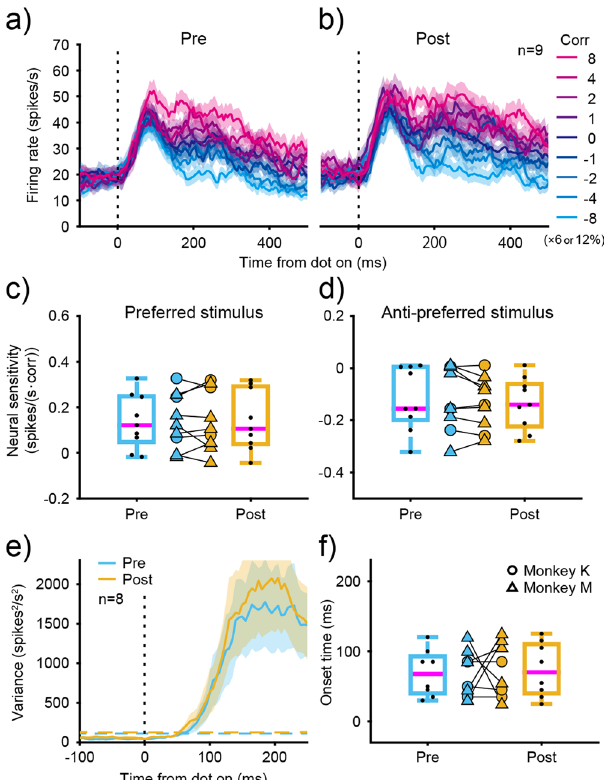
Fig. 6 Effects of ketamine on MT responses during the direction- discrimination task. Average fi ring rates of 9 MT neurons aligned to visual stimulus onset are plotted before ( a ) and after ( b ) ketamine administration. Each colored line denotes fi ring rates at different binocular correlation with motion coherence fi xed at zero. Dotted-vertical line denotes the time of visual stimulus onset. Shaded area denotes SEM. c , d MT sensitivity to binocular correlation before and after administration. The binocular correlation-dependent increase in fi ring rate was evaluated for each neuron separately for preferred ( c ) and anti-preferred stimuli ( d ). Circles and triangles denote each experimental data for monkey K and monkey M, respectively. Boxplot conventions are the same as in Fig. 2. e Average fi ring rate variance of 8 MT neurons before and after administration. Firing rate variances among different motion coherence with binocular correlation fi xed at zero are plotted for the direction-discrimination task. Response traces are aligned to visual stimulus onset. Dashed-horizontal lines denote threshold corresponding to three standard deviations above the baseline. Blue denotes before administration, and yellow denotes after administration. Dotted-vertical line denotes the time of visual stimulus onset. Shaded area denotes SEM. f Onset time of MT neurons before and after administration. Boxplots show the onset time for the direction- discrimination task before and after ketamine administration. Boxplot conventions are the same as in Fig.